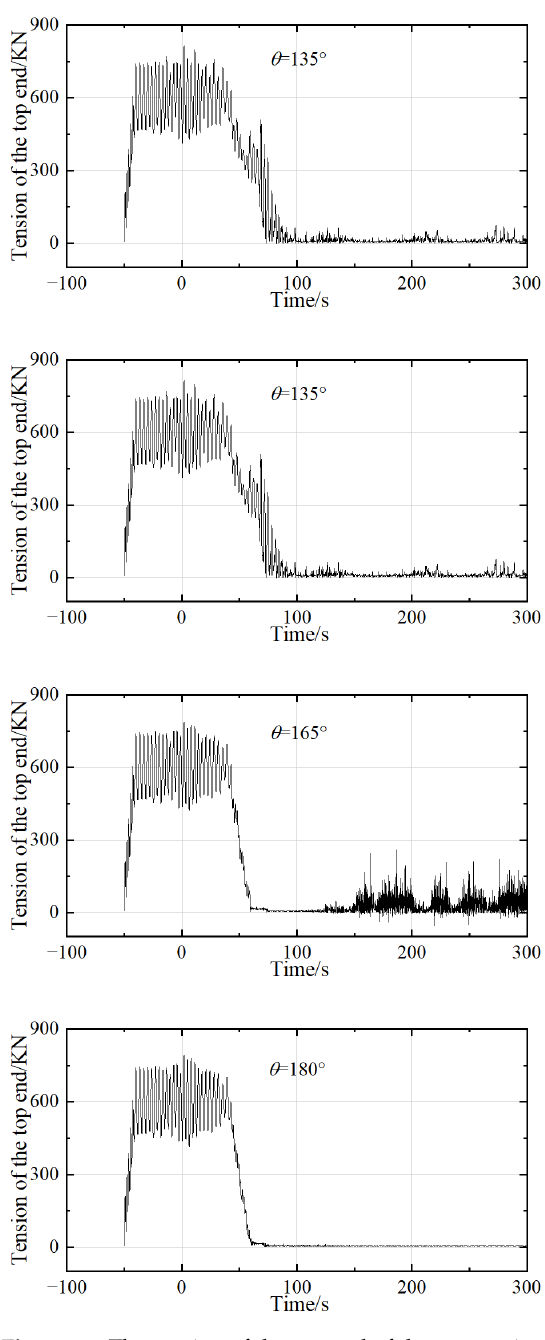
Figure 12. The tension of the top end of the crane wire under different wave directions.